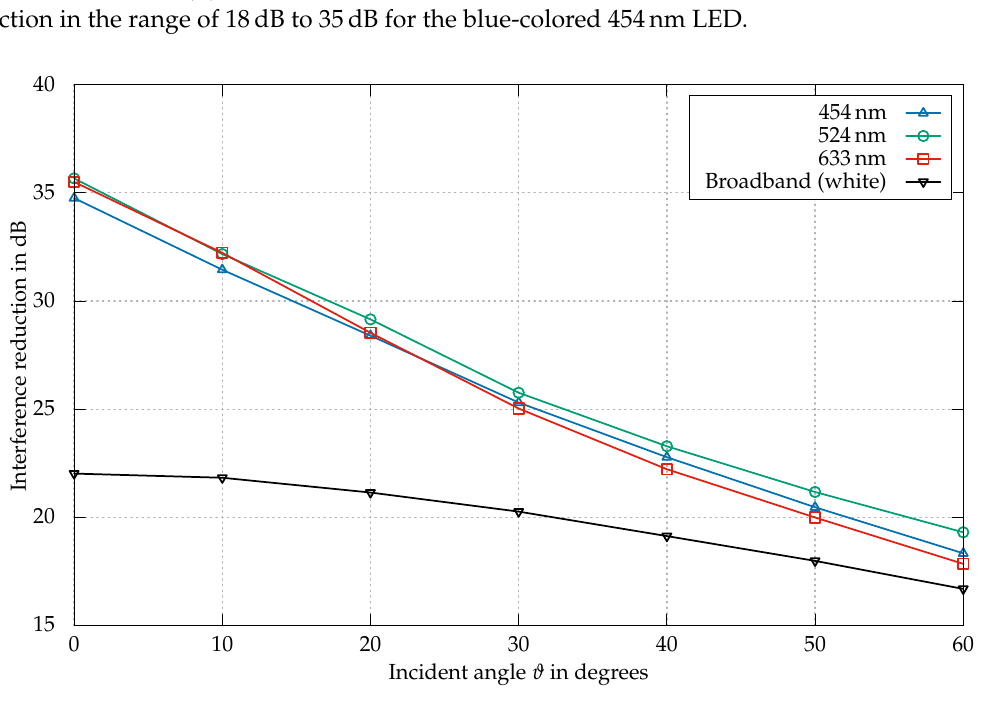
Figure 6. Reduction of modulated interference, according to the analytical method described in Section